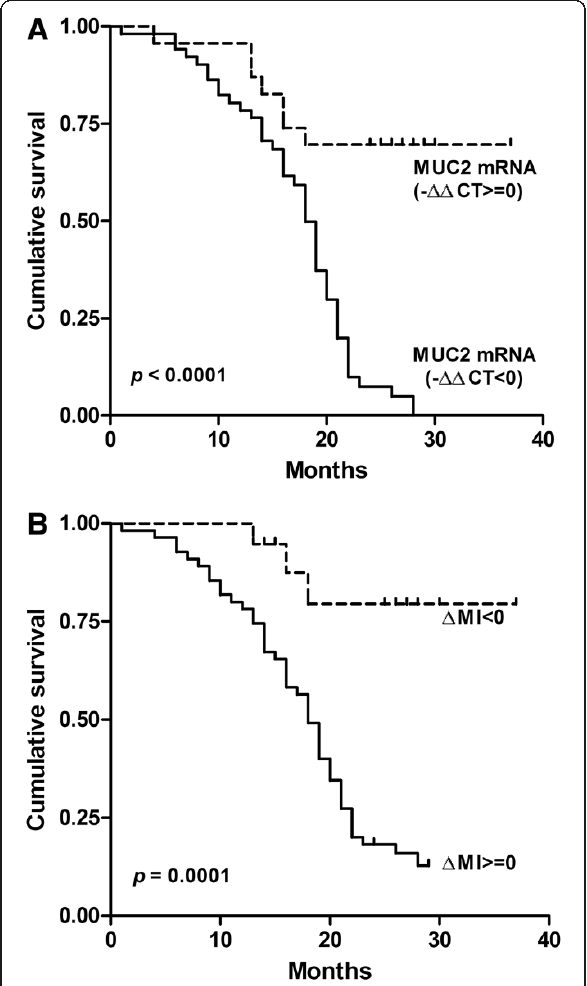
Figure 4 MUC2 mRNA and hypermethylation confers poor prognosis in HCC. ( A ) Kaplan – Meier analysis of survival months after surgery according to MUC2 mRNA level. ( B ) Kaplan – Meier analysis of survival months after surgery according to MUC2 methylation